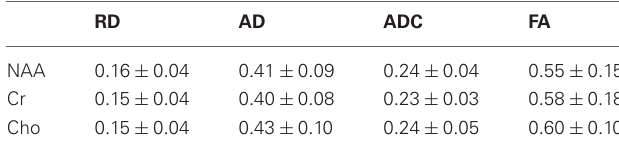
Table 1 | Diffusion data in the healthy human white